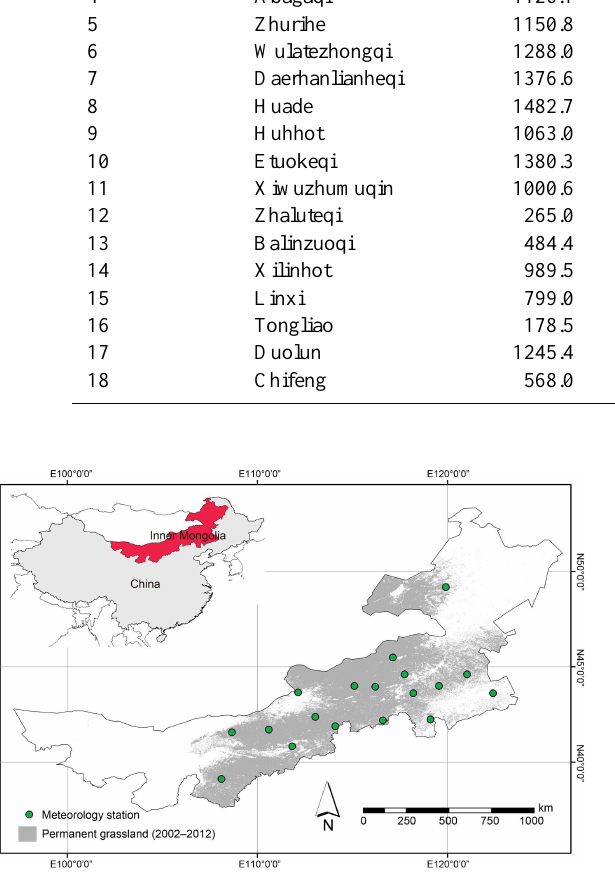
Figure 1. The Inner Mongolia Autonomous Region (IMAR). The gray part represents the permanent grassland area, whereas the black dots represent the selected meteorology